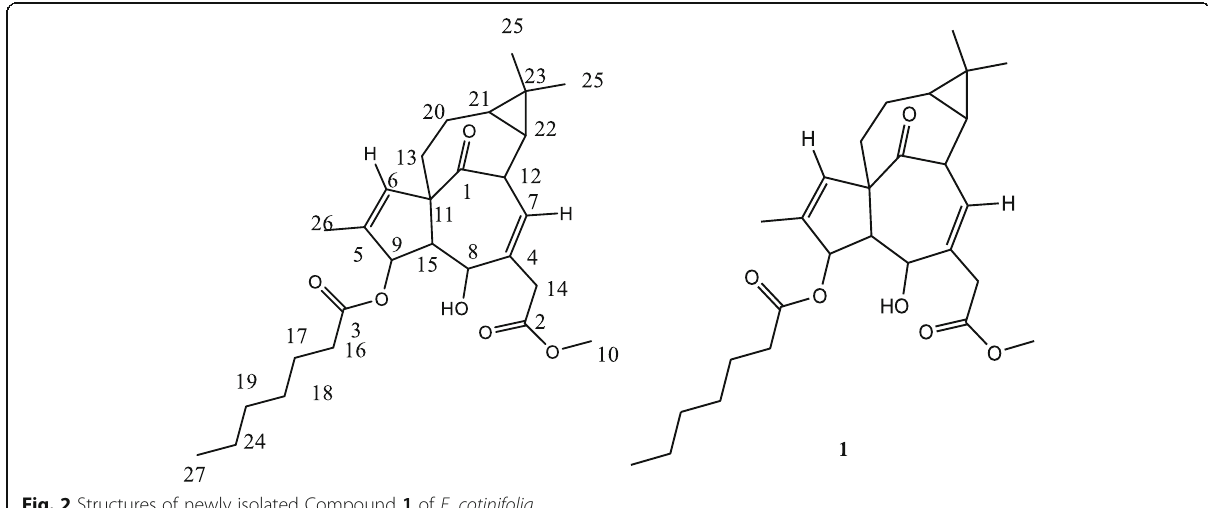
Fig. 2 Structures of newly isolated Compound 1 of E.